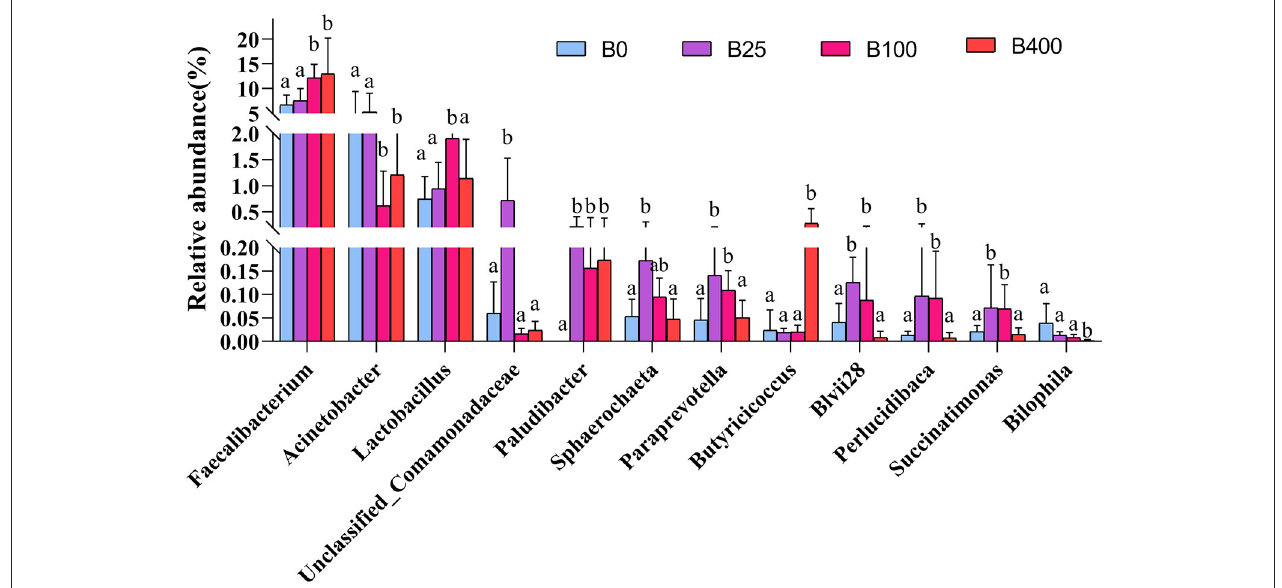
FIGURE 4 | The relative abundance of cecal microbiota of layers fed diets with different levels of vitamin B 12 at genus level only statistically significant differences are shown. Bars with different superscript letters were significantly different ( P <